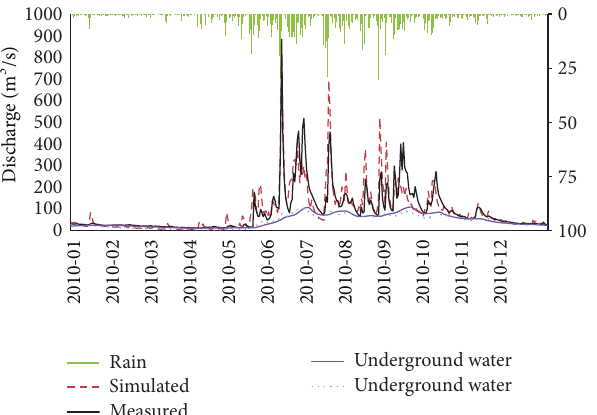
Figure 11: XAJ model validation phase (2012). Measured and simu- lated discharge, the groundwater runoff separated from the hydro- graph and calculated by Xin’anjiang model, and catchment average rainfall time